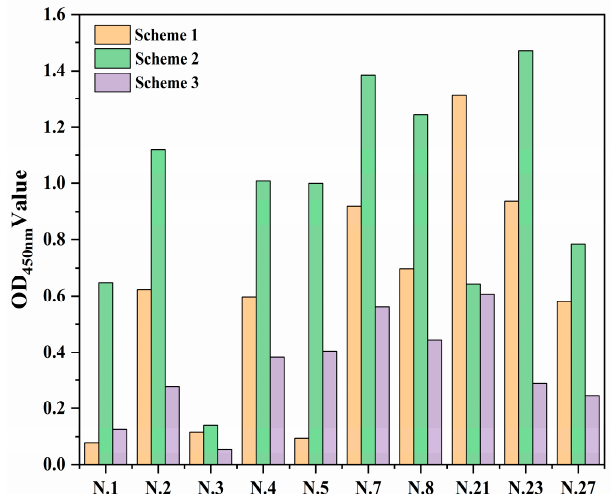
Figure 2. Fixation effect of antibody protein on linear materials under three different pretreatments of ddH 2 O (Scheme 1), dilute acid treatment (Scheme 2), and citric acid modification (Scheme 3).